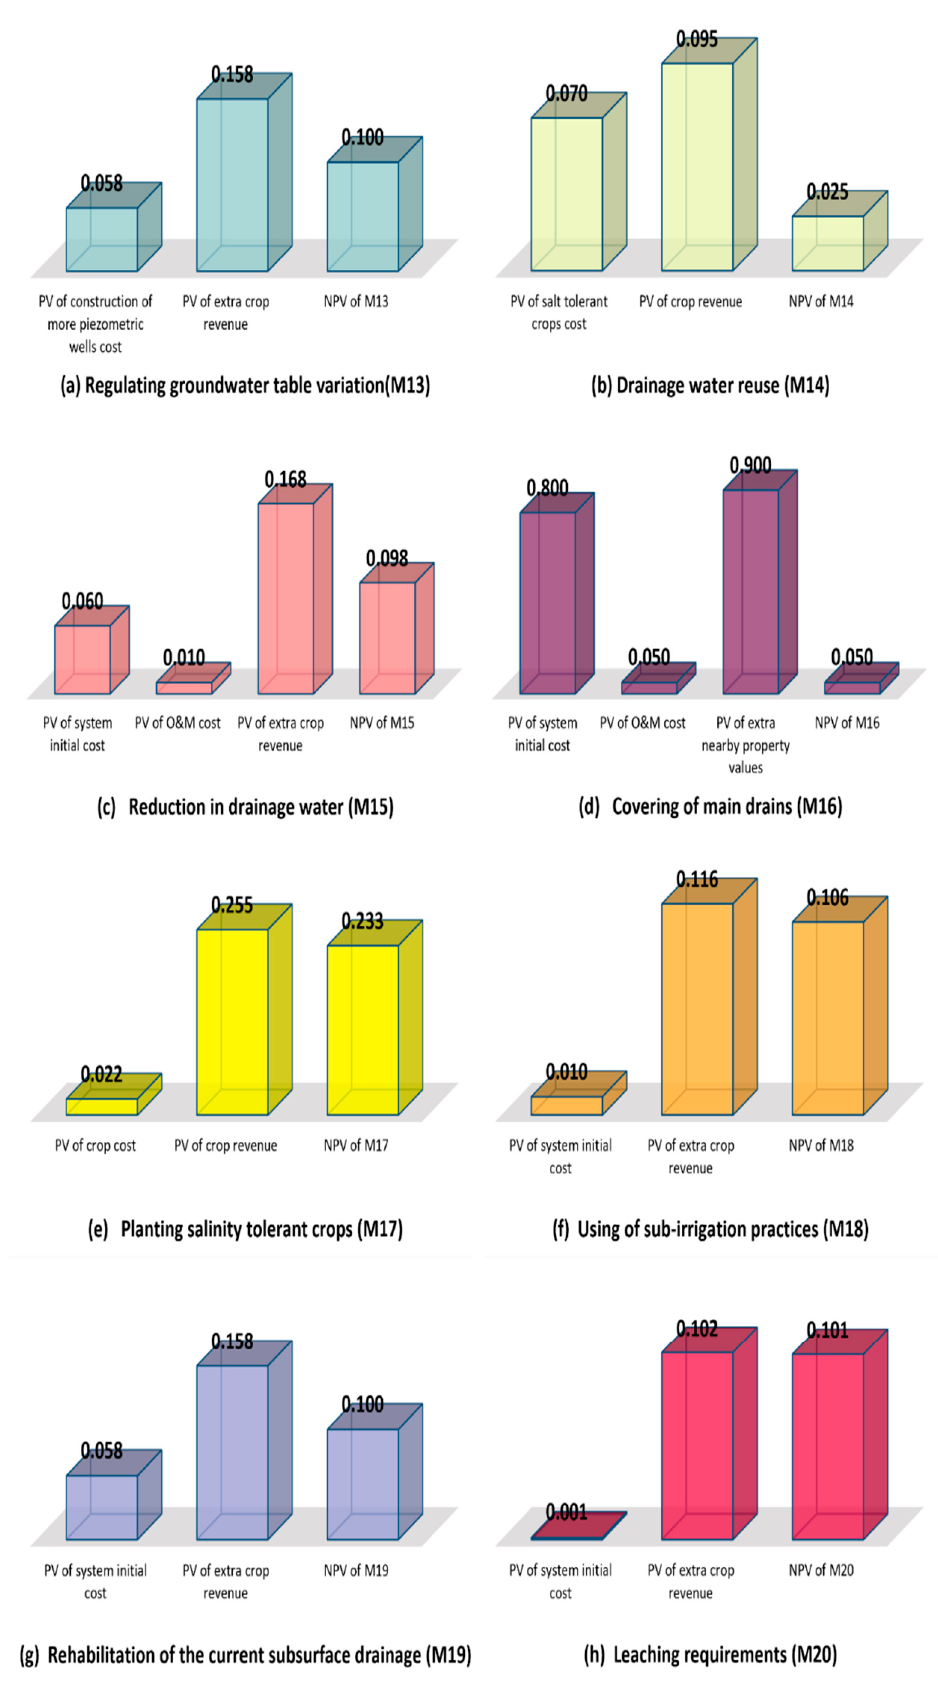
Figure 5. Costs, benefits and NPV ($/m 2 ) for M 13 , M 14 , M 15 , M 16 , M 17 , M 18 , M 19 , and M 20 .